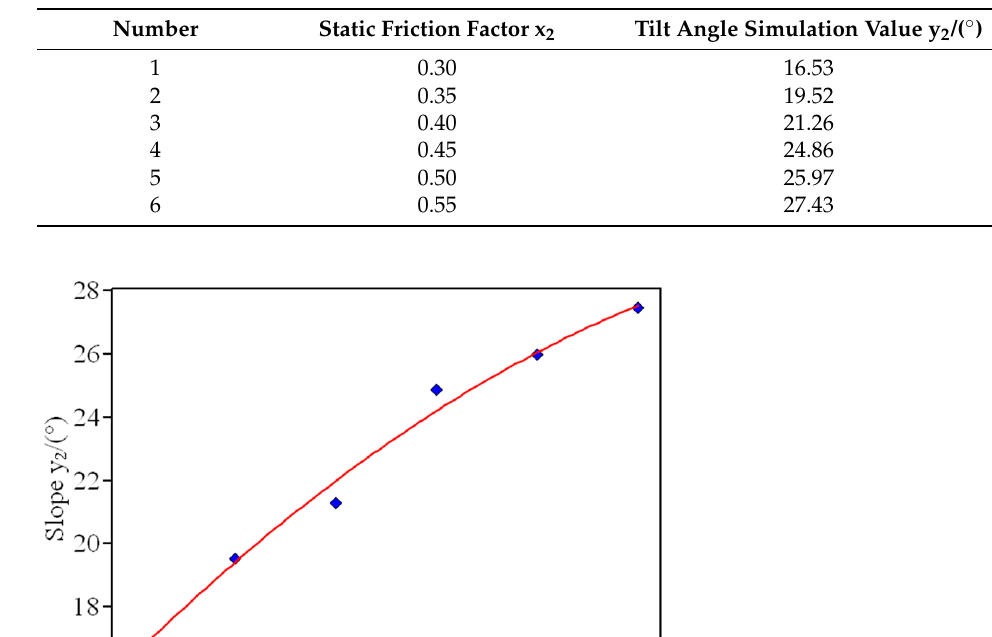
Figure 5. Calibration experiment of static friction coefficient. ( a ) Physical experiment; ( b ) Simulation test. 1. Q235 steel; 2. Lily Bulb; 3. Digital display angle ruler.